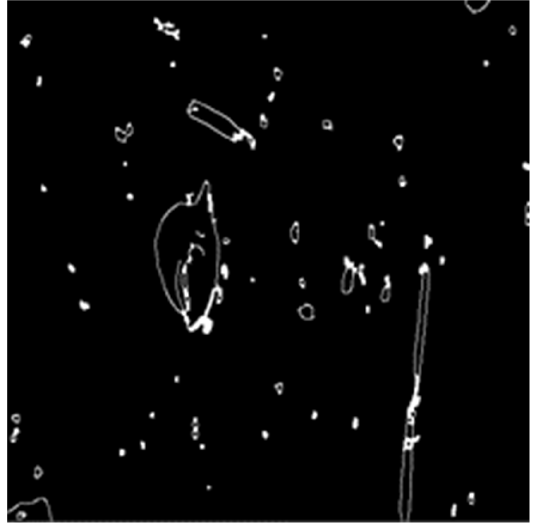
Figure 10. Closing operation.